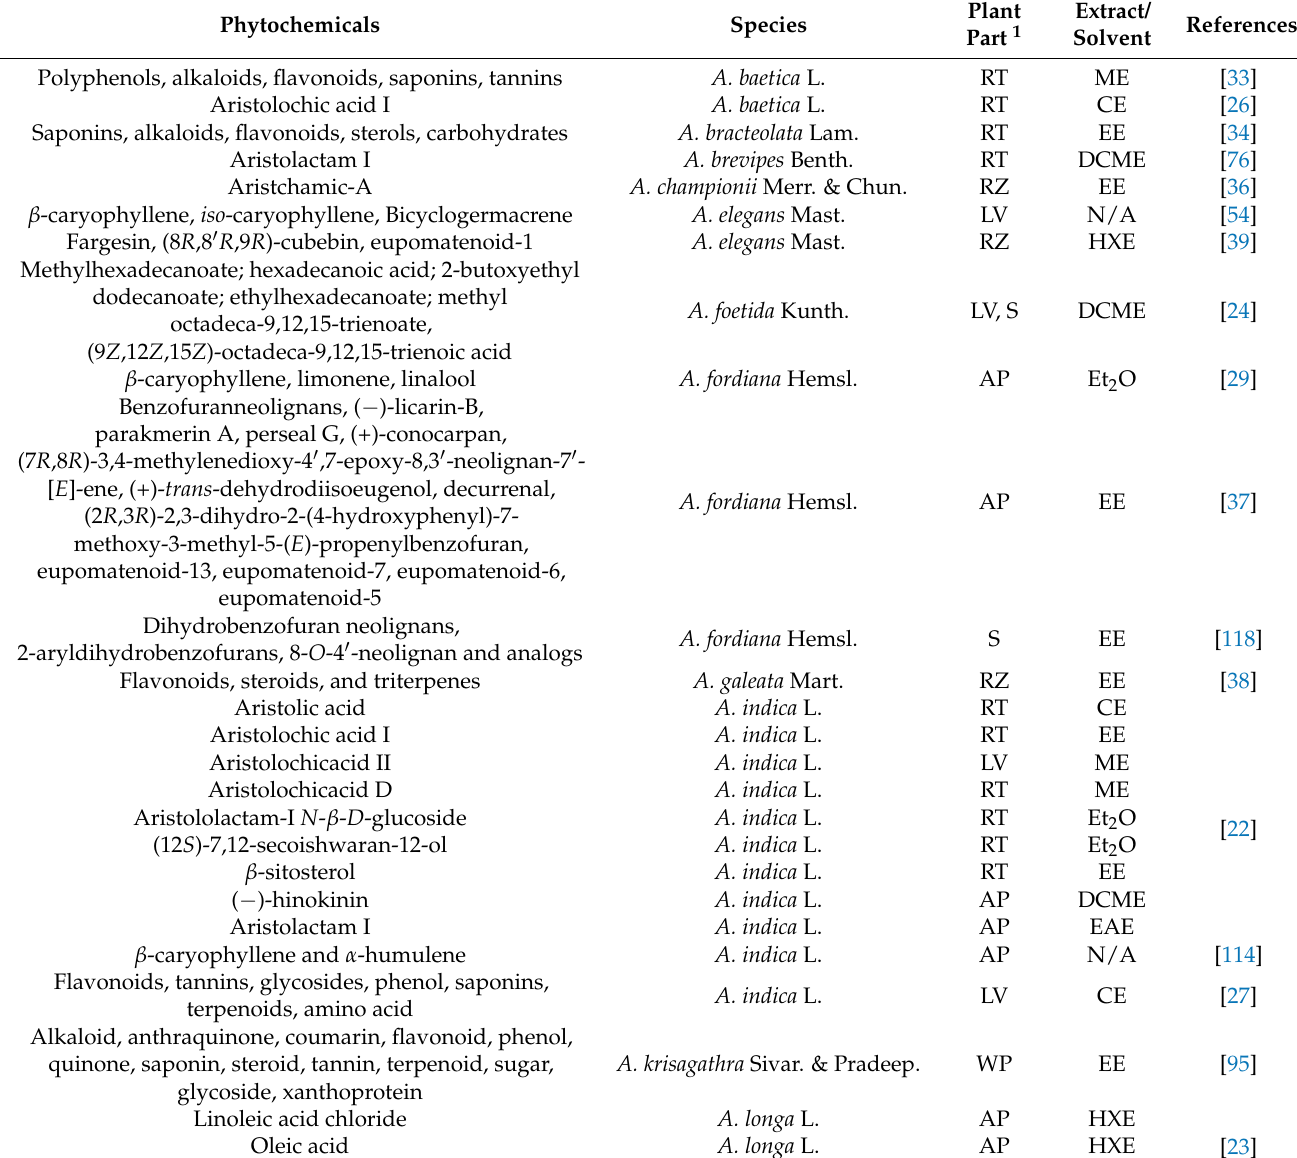
Table 1. Main phytochemicals of species of the genus Aristolochia , using different solvents. Phytochemicals Species